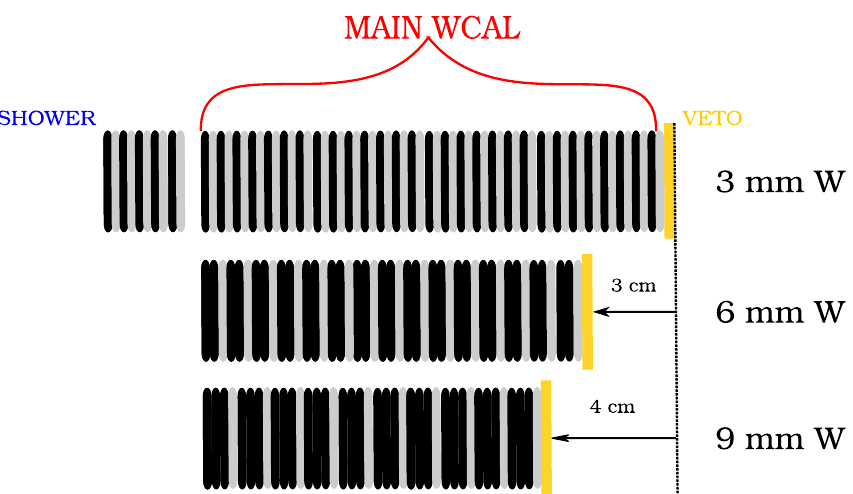
Fig. 8 Possible designs of the WCAL re-arranging the available tiles of 3 mm of Tungsten (W) and 2 mm of scintillator material. All designs posses the same WCAL thickness of 30 X